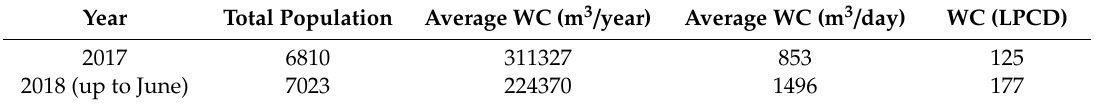
Table 3. Water consumption (WC) in liter per person per day (LPCD) of 2017 and